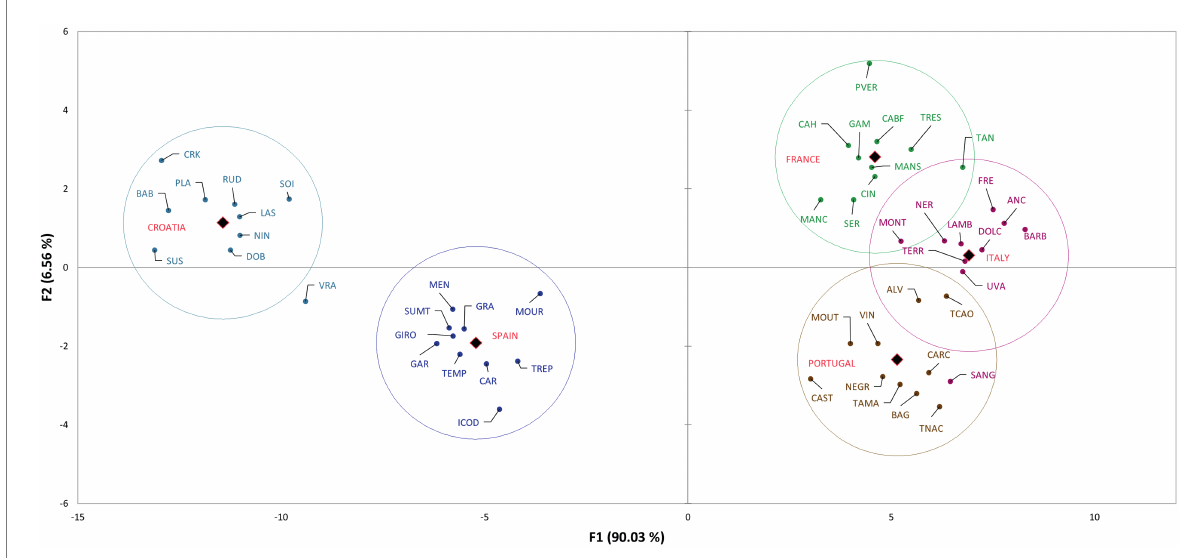
FIGURE 2 The scatter plot of discriminant analysis representing cultivars from different